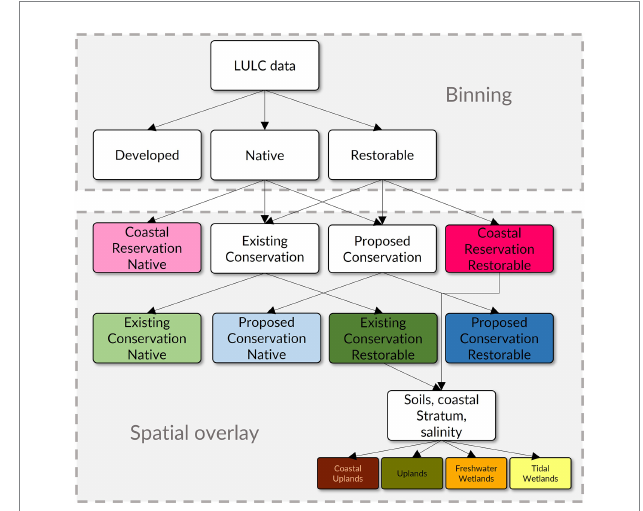
FIGURE 2 Spatial analysis workflow used to identify opportunity areas (existing conservation native, proposed conservation native, existing conservation restorable, proposed conservation restorable, reservation native, reservation restorable) and restoration potential (coastal uplands, uplands, freshwater wetlands, tidal wetlands) in the Tampa Bay watershed. Workflows are divided into binning of land use/land cover categories into relevant habitat types and spatial overlay of datasets to identify the opportunity areas and restoration potential. The approach was applied to both the intertidal and supratidal strata of the